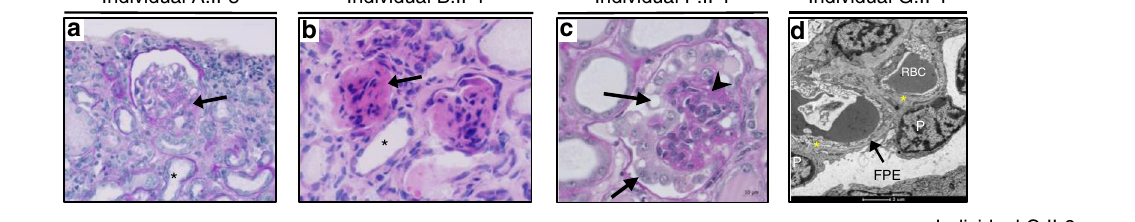
children), and a longer survival compared to the YRDC cases.